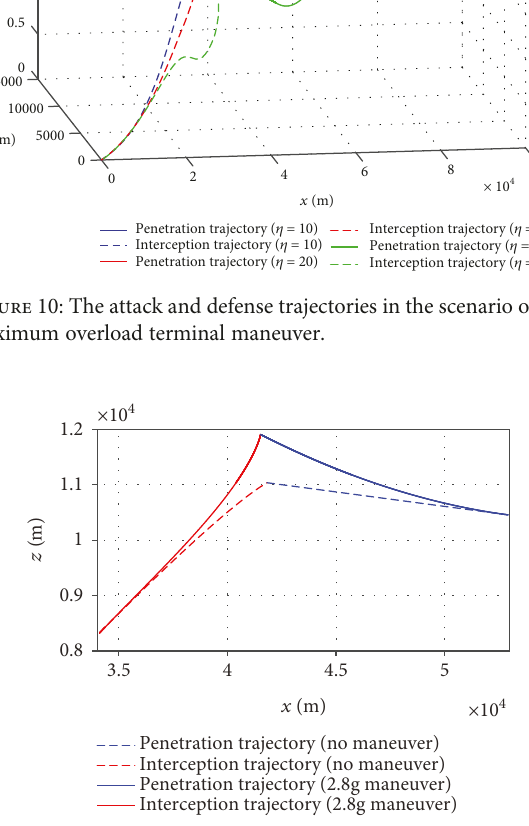
Figure 11: The attack and defense trajectories in the scenarios of no maneuver and maximum overload maneuver (horizonal plane).